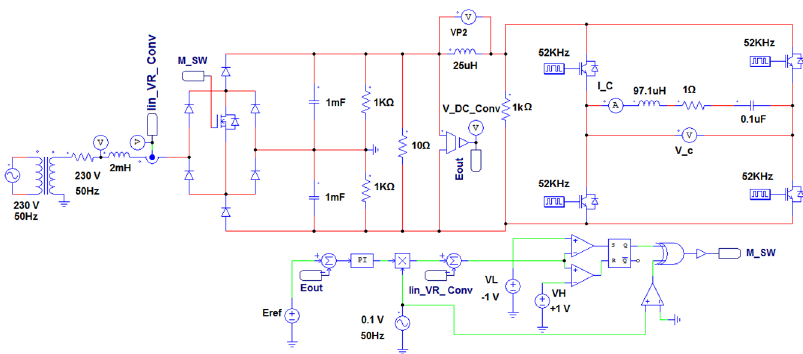
Figure 14. Simulation circuit diagram of an IH system with a conventional VR.